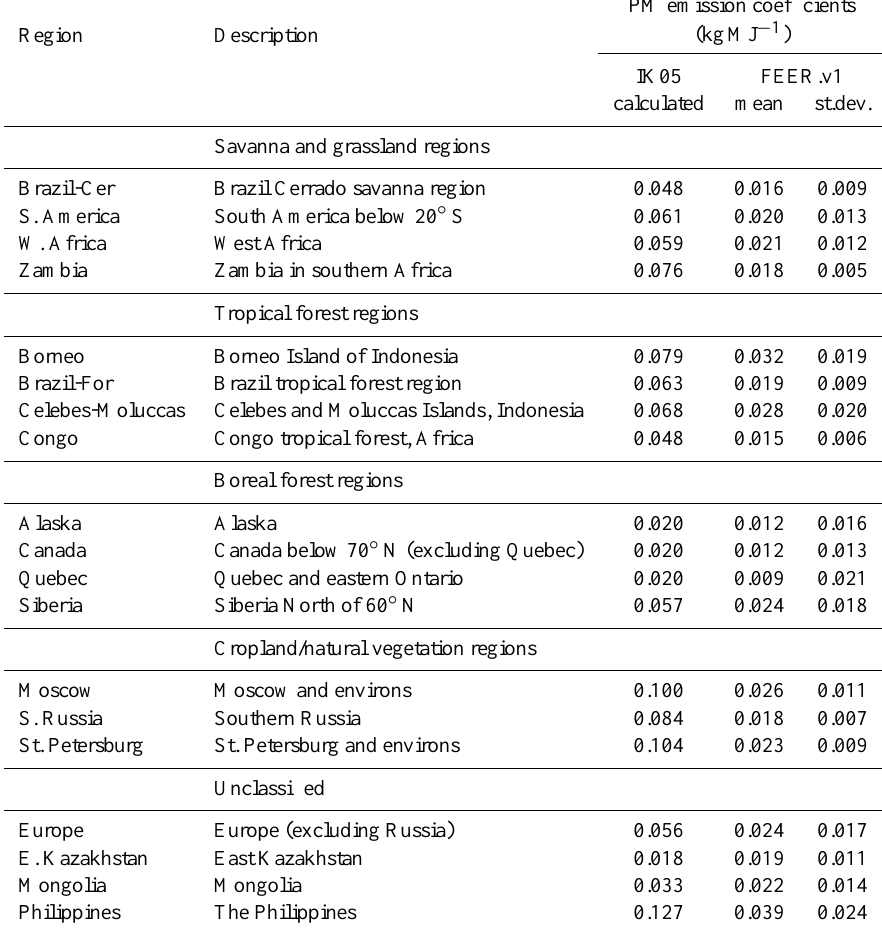
Table 5. Estimates of regional FRE-based smoke-aerosol emission coefficients ( C e ) from MODIS are shown here for different regions using both the original method as reported in Ichoku and Kaufman (2005) and version 1 of the new FEER C e product